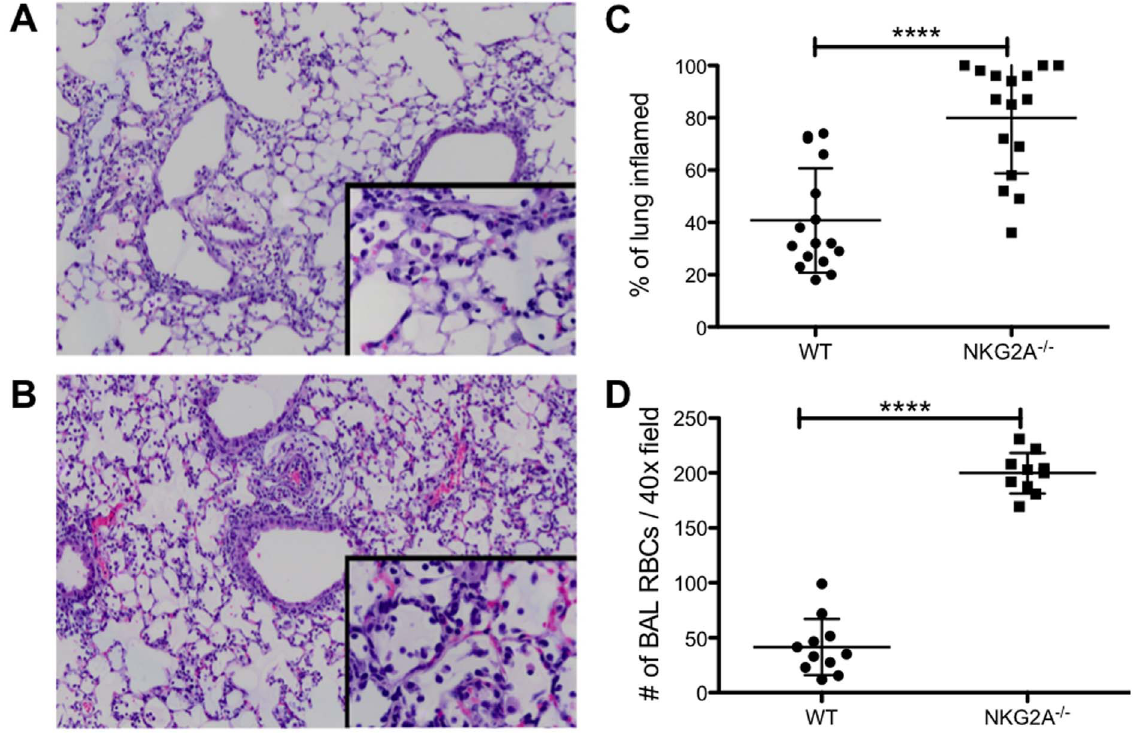
Figure 8. Transferred NKG2A 2 / 2 CD8 + T cells are more inflammatory following intranasal influenza PR8 infection than transferred WT CD8 + T cells. Whole lung histology on day 5 post-infection from mice receiving either (A) WT or (B) NKG2A 2 / 2 NP 366 -specific CD8 + T cells after lethal challenge with influenza A/PR8/34 virus. Shown are representative slides from at least 2 separate experiments at 10 6 and 40 6 (inset) with overall histolopathological score was determined as described in Materials and Methods(C). Hemorrhage after T cell transfer was enumerated by counting the number of RBCs from multiple 40 6 fields of tissues from multiple mice (D). Data are representative of the results of two experiments with 3–5 recipient mice per group. * p , 0.0001.